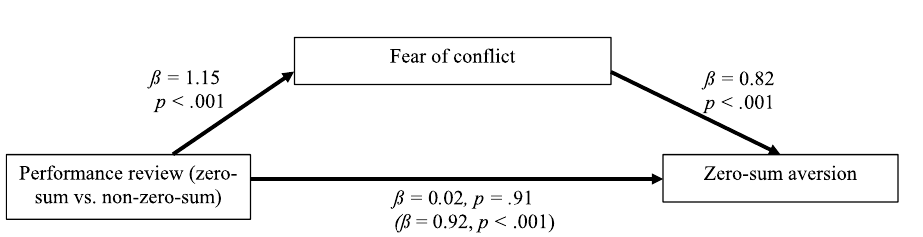
Figure 1. The likelihood of choosing the zero-sum option in each condition (Study 3B).